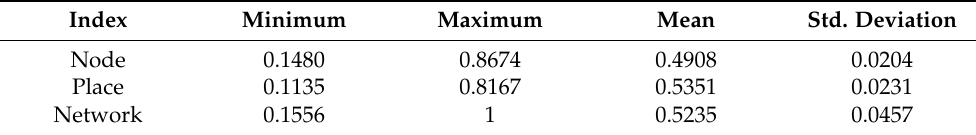
Table 4. Descriptive statistics of the node, place, and network